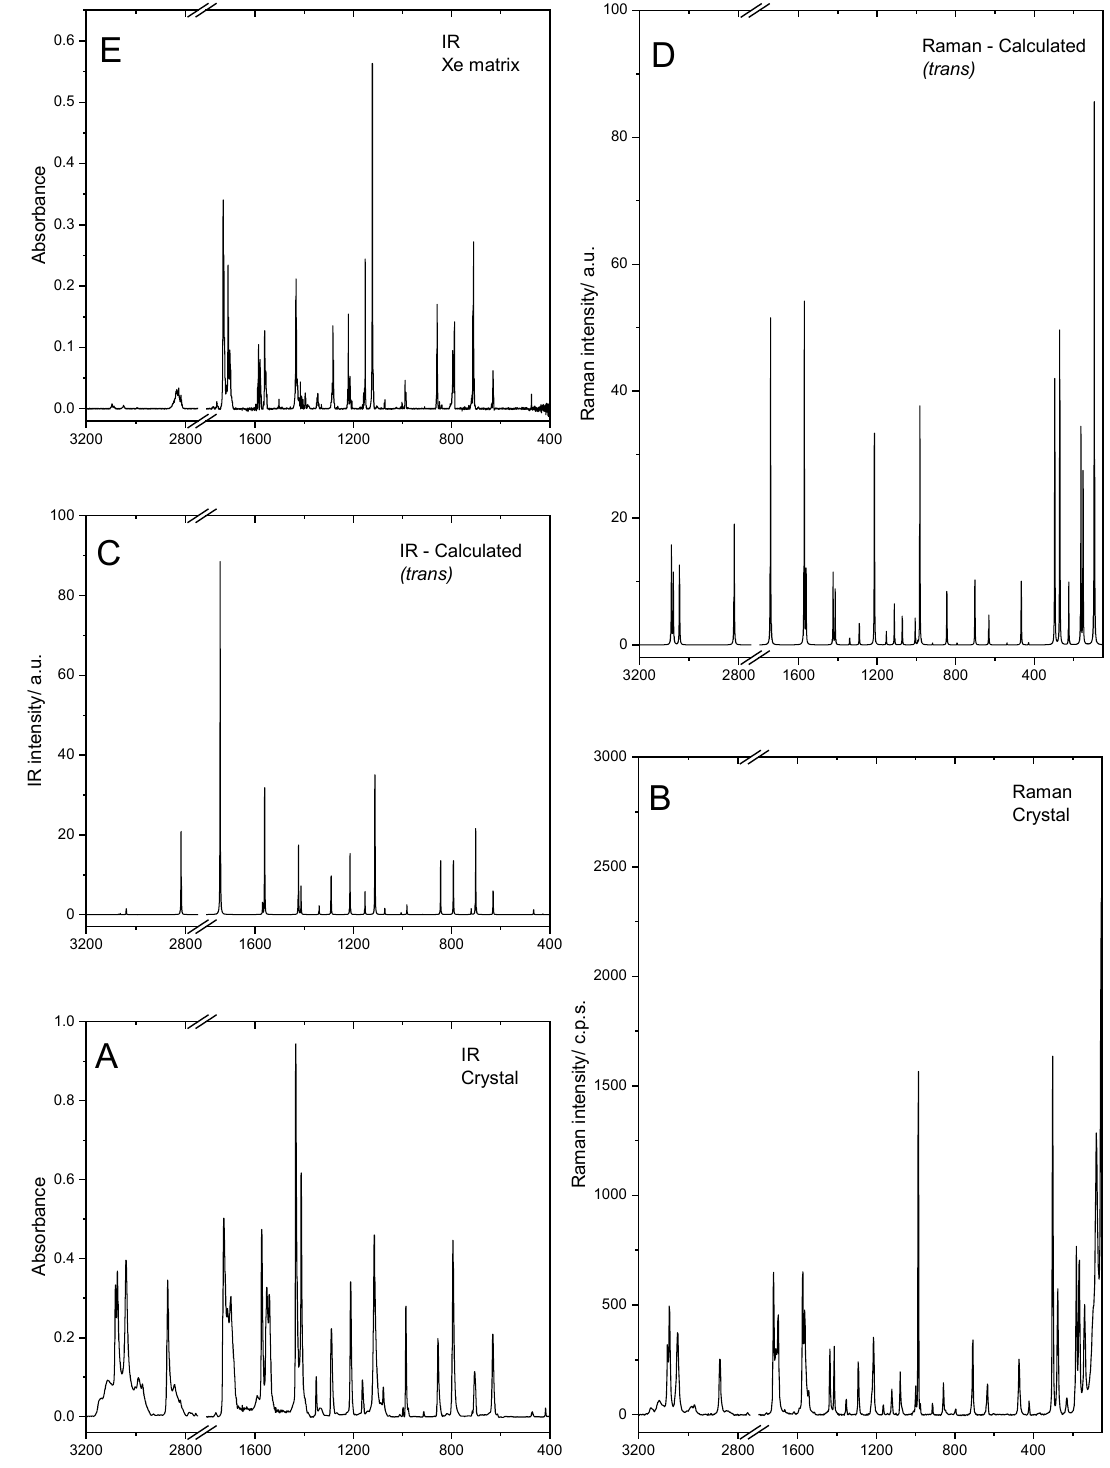
Figure 5. Experimental room temperature IR ( A ) and Raman ( B ) spectra of crystalline neat BPCA, compared to the corresponding simulated spectra built based on the DFT(B3LYP)/6-311++G(d,p) data ( C , D ). The spectrum of the isolated compound in the Xe matrix at 15 K is also shown for comparison ( E ). The calculated frequencies were scaled as described in Section 3.